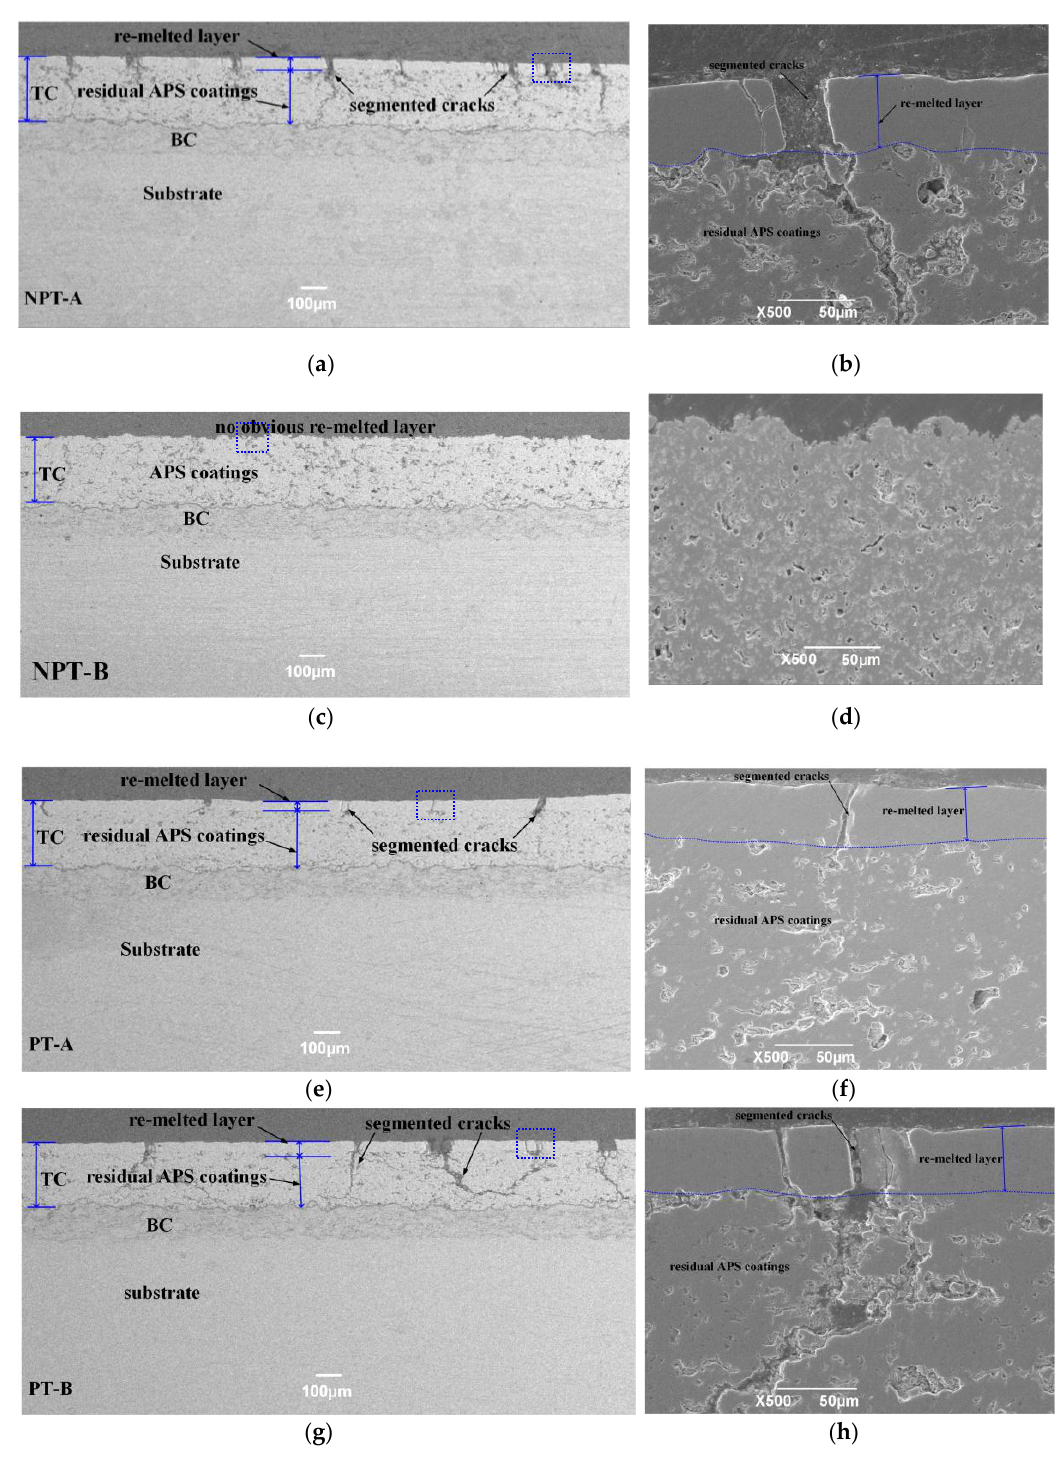
Figure 4. SEM images showing cross-sectional microstructures of ( a , b ) NPT-A, ( c , d ) NPT-B, ( e , f ) PT- A, and ( g , h ) PT-B samples, respectively. and ( g , h ) PT-B samples,